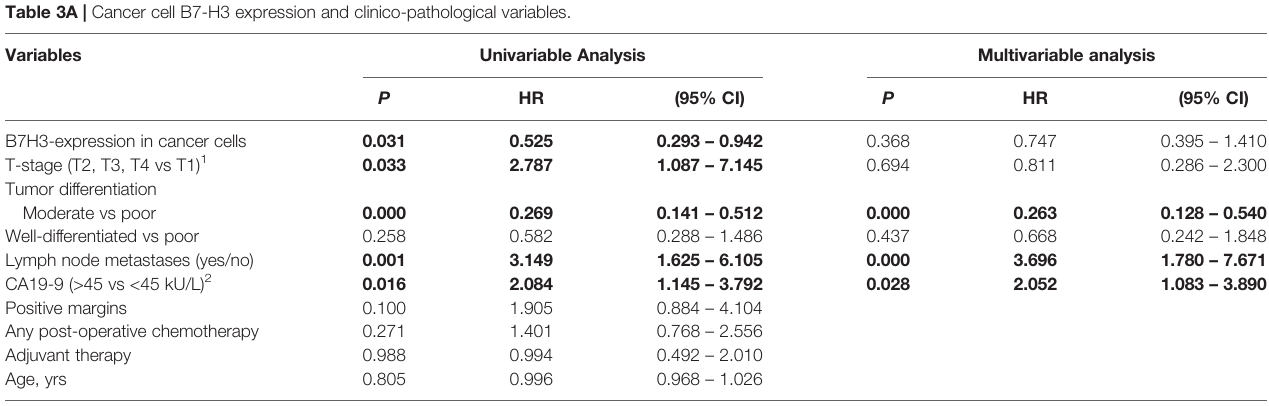
Table 3A | Cancer cell B7-H3 expression and clinico-pathological variables.